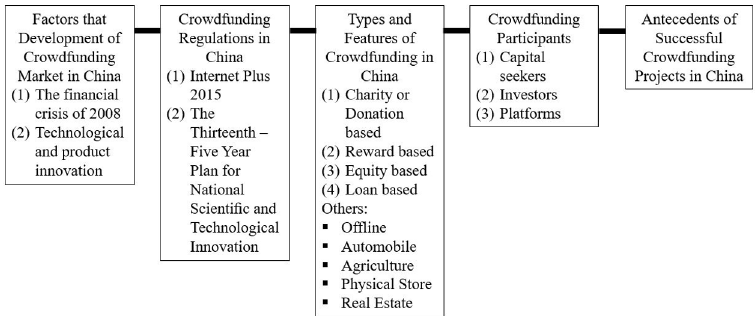
Figure 1. A framework